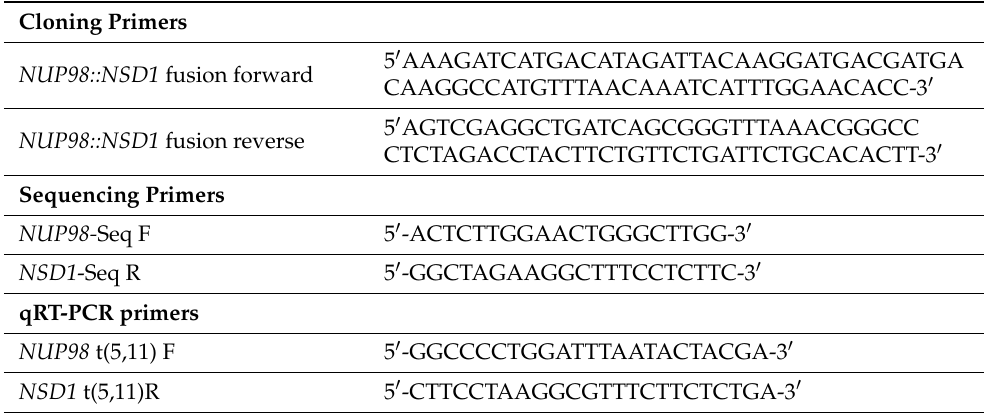
Table 1. List the primers and probes used for cloning, sequencing, expression analysis, and frag- ment